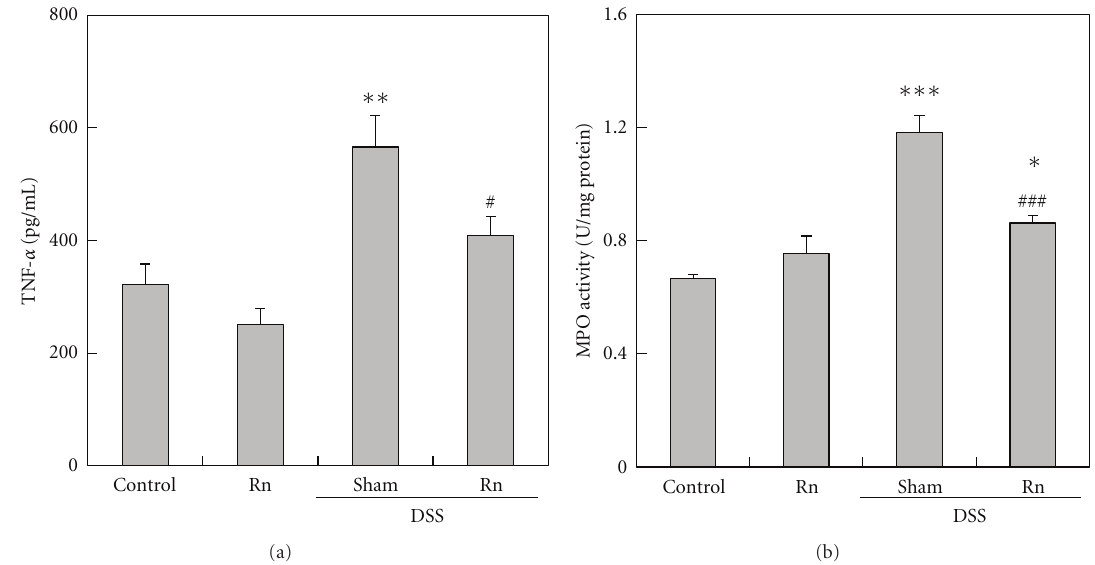
Figure 4: E ff ects of radon inhalation on inflammation-associated substances after colitis induction. (a) TNF- α in plasma and (b) MPO activity in the colon. Each value is the mean ± SEM. The number of mice for each experiment was 7-8. The significance is the same as in Figure